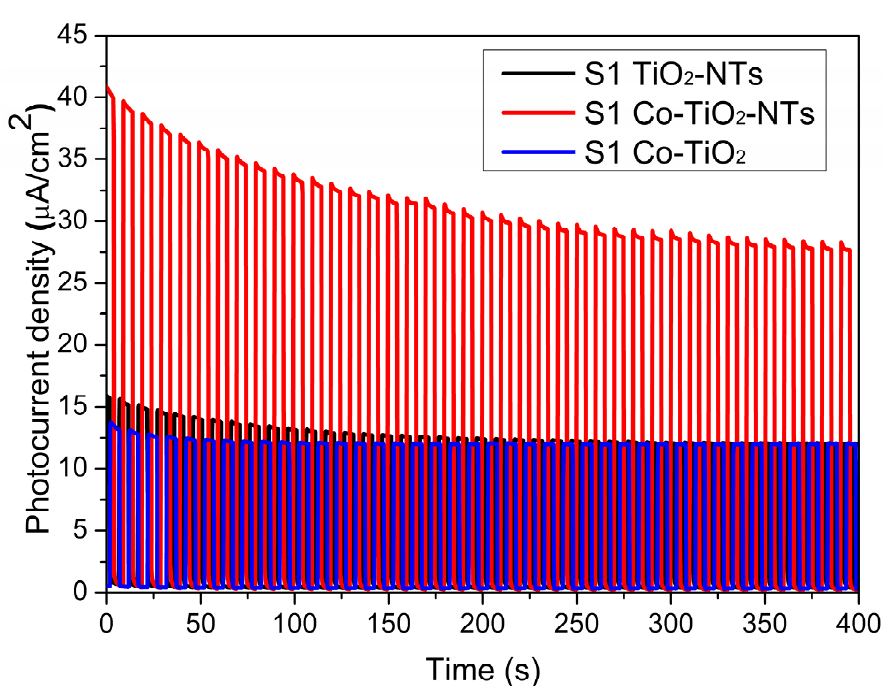
Figure 9. The chronoamperometry curve, showing the photocurrent density, registered for modified and pure titania electrodes at E = + 0.5V. Source of light: 150 W xenon lamp equipped with an AM1.5 filter, light intensity: 100 mW·cm 2 .